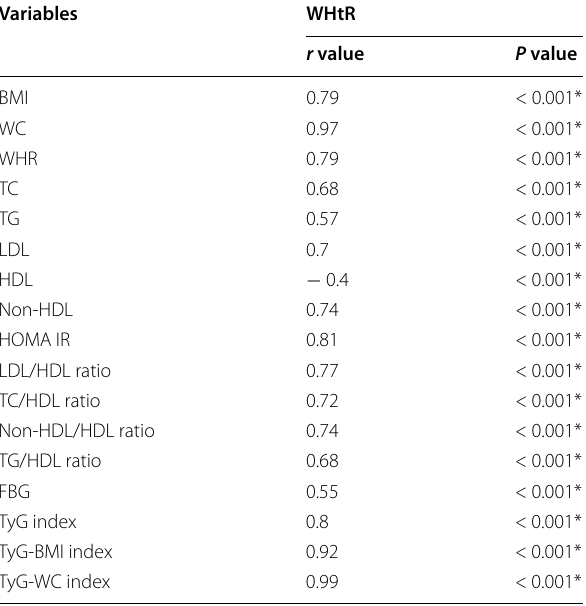
clinical and laboratory parameters in the study